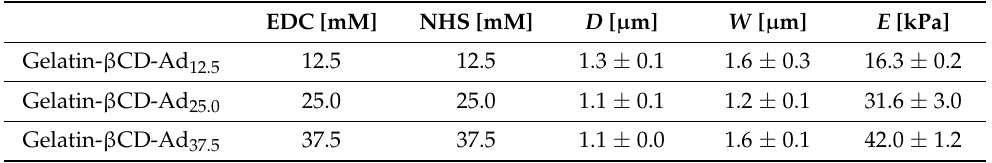
Table 1. Thickness D , width W , and Young’s modulus E of gelatin- β CD-Ad fibers crosslinked at different concentrations of EDC and NHS ( N = 4).